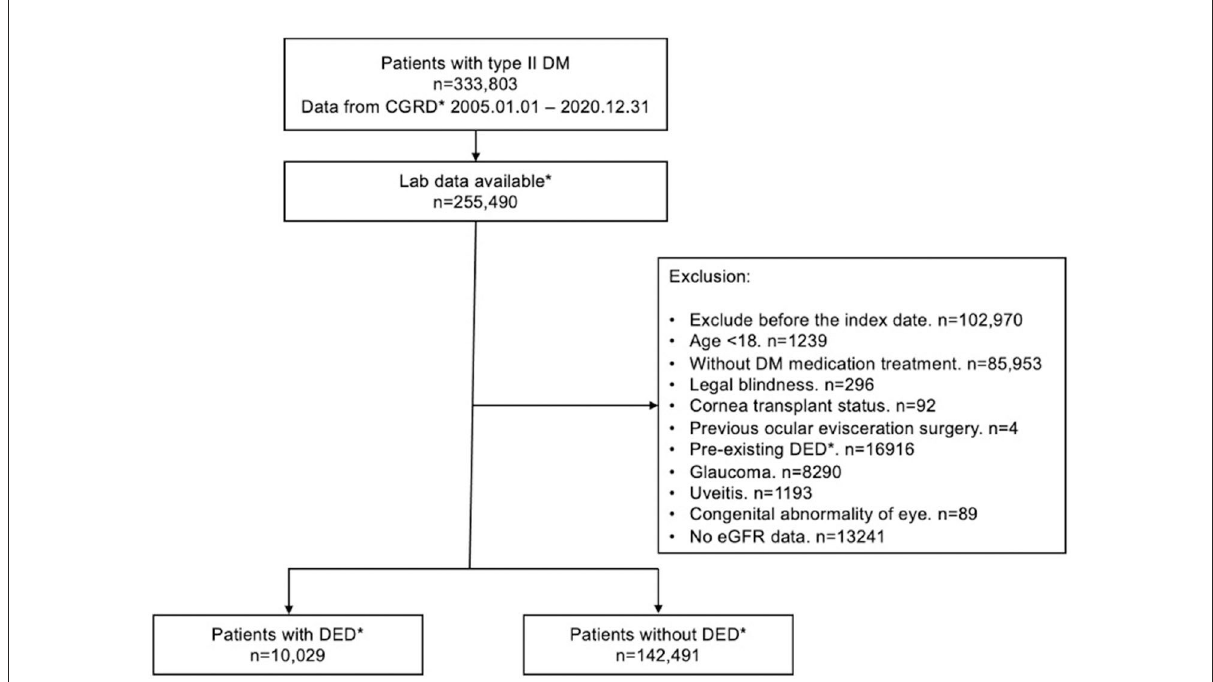
FIGURE1 Flow chart for inclusion and exclusion of patients from the CGRD. CGRD, Chang Gung Research Database. DED, dry eye disease; Laboratory data available: with available HbA1c data.